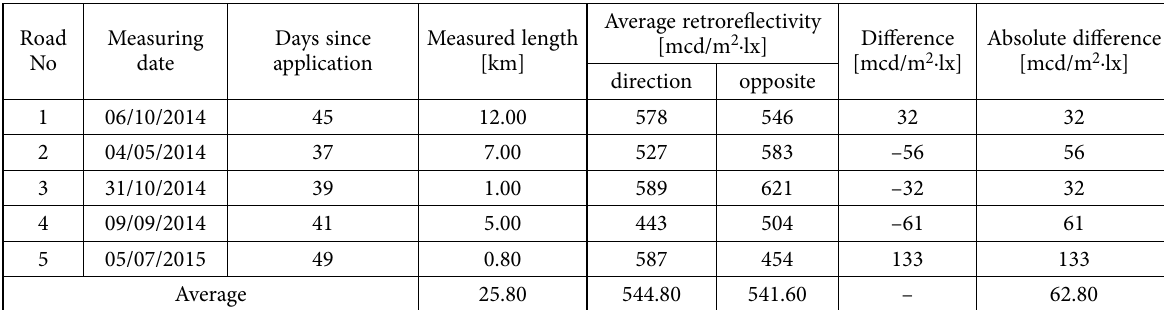
Table 5. Results of retroreflectivity measurement in the direction of application and the opposite direction for renewed structural markings made of cold plastic